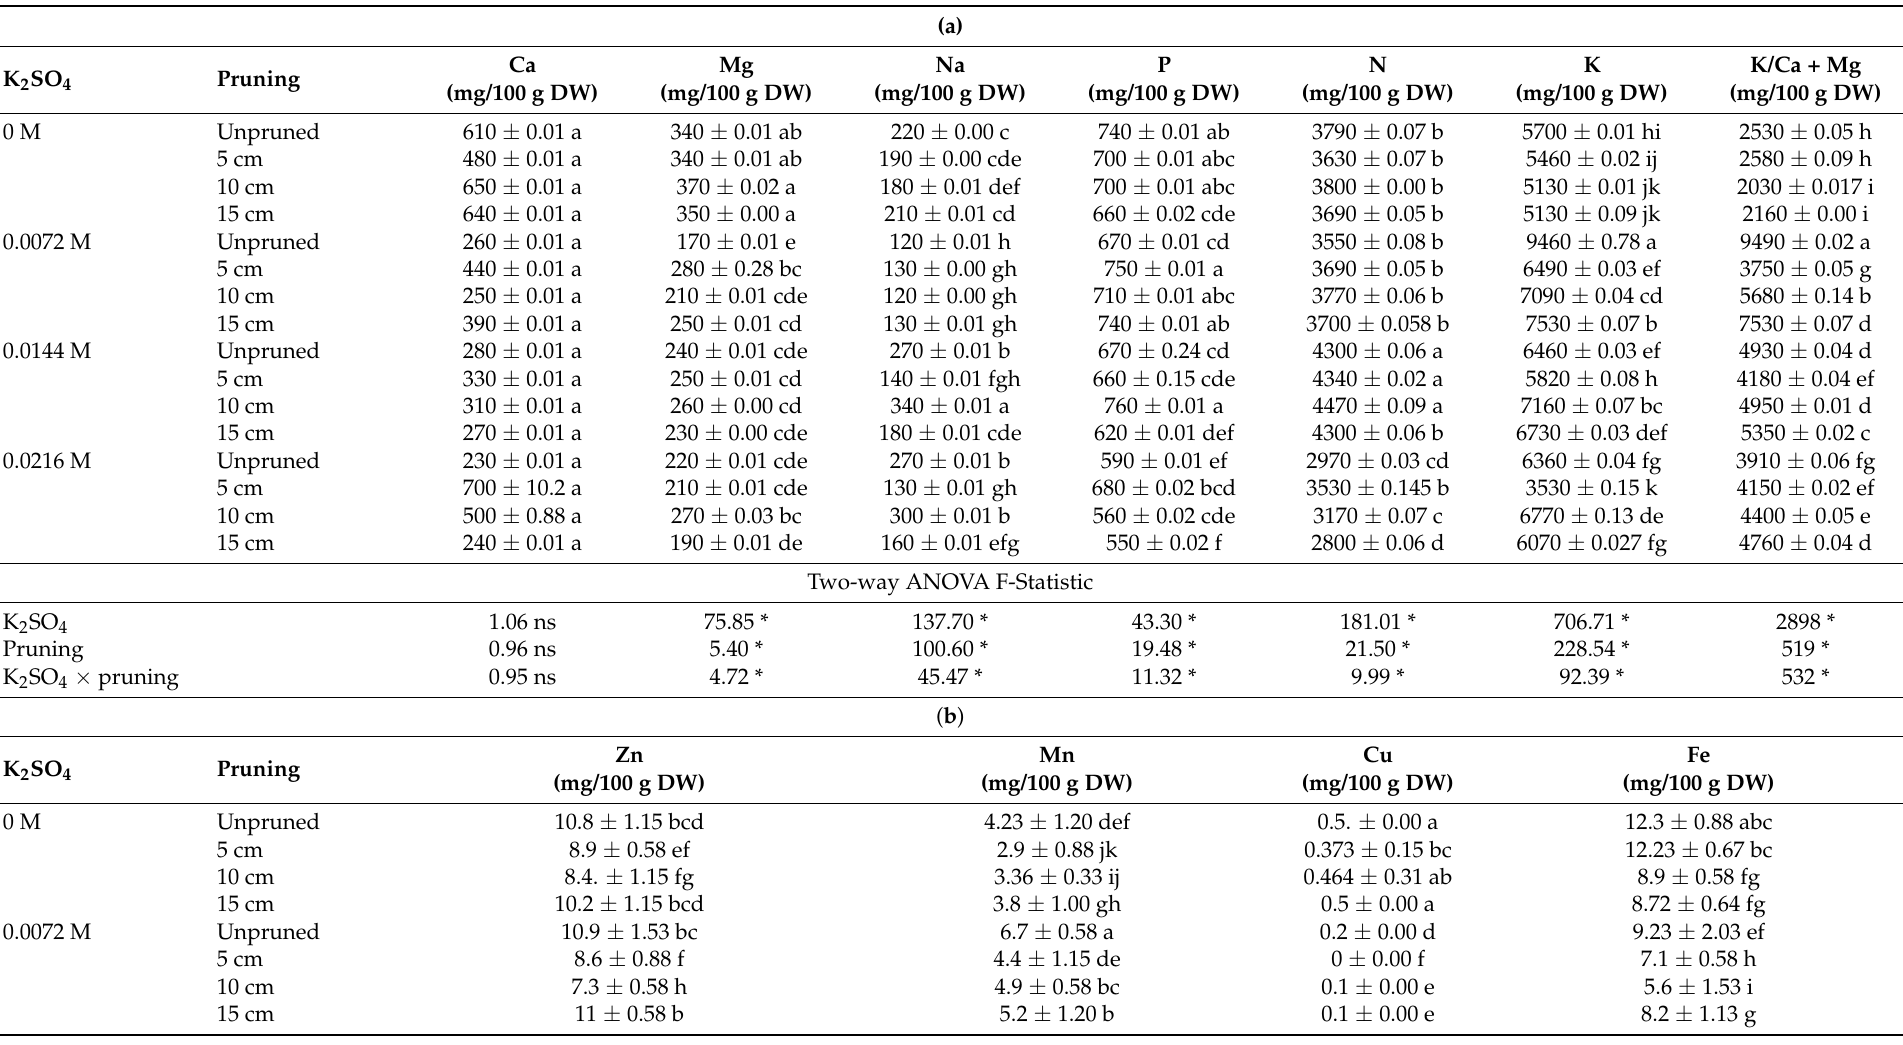
Table 3. ( a , b ) The effect of potassium dosage and pruning levels on macronutrients of flower buds of hydroponically grown T. divaricata .